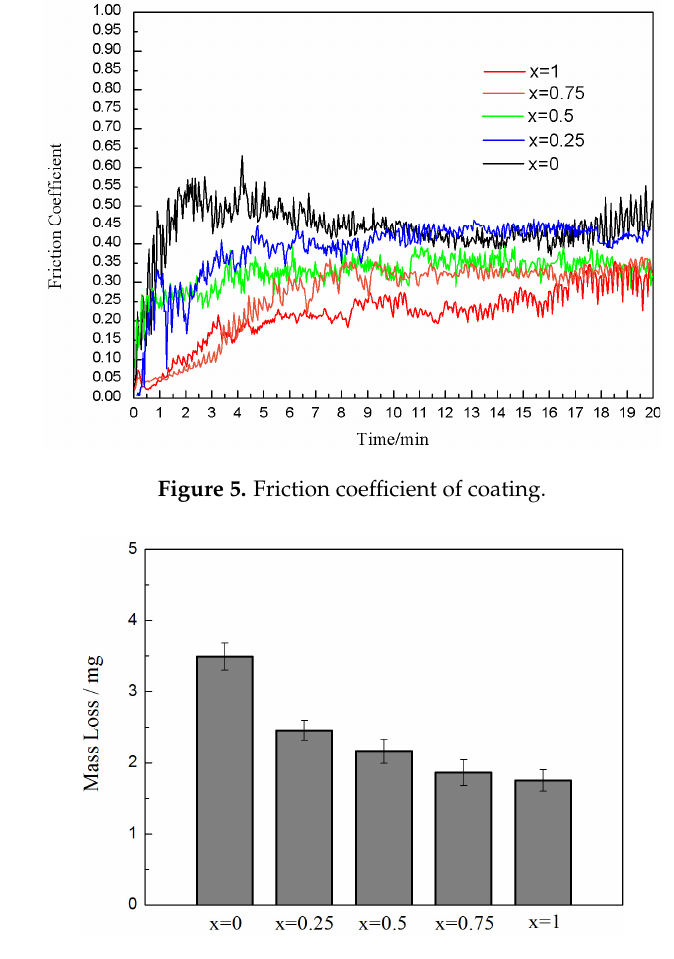
Figure6. Mass loss of FeCoCrNiAlTi x coatings . Figure 6. Mass loss of FeCoCrNiAlTi x